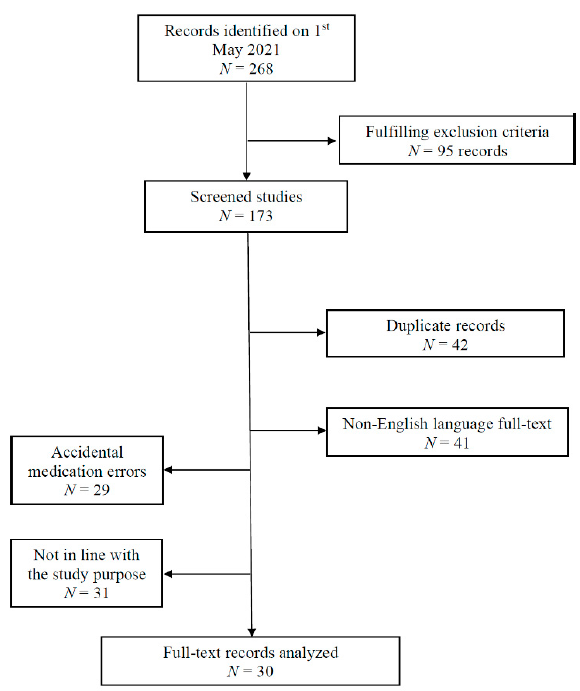
Figure 5. Flowchart illustrating studies included and excluded in this literature review.